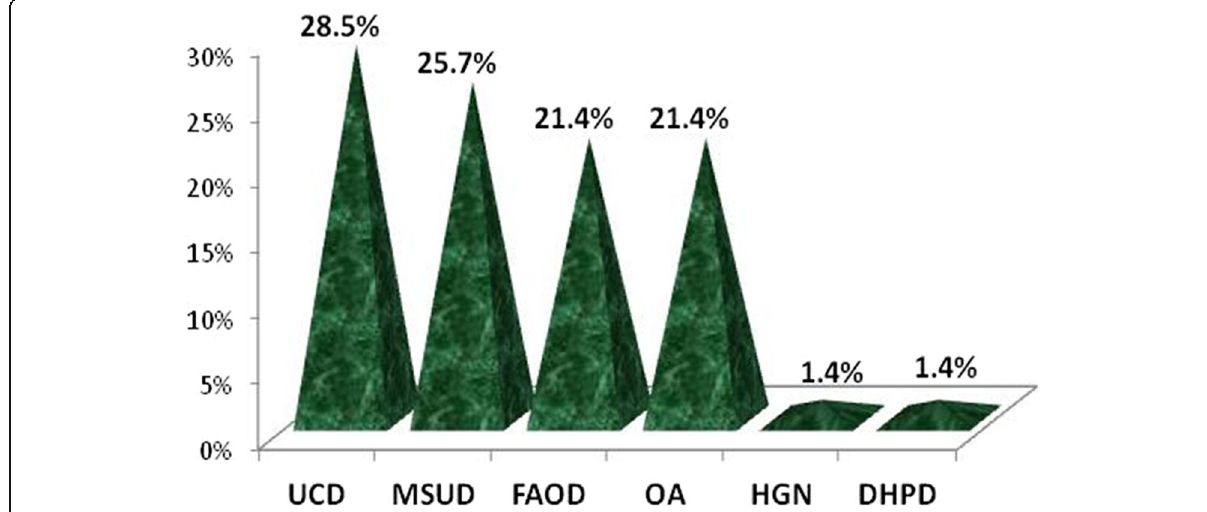
Fig. 2 IEM Subcategory prevalence among the studied IEM